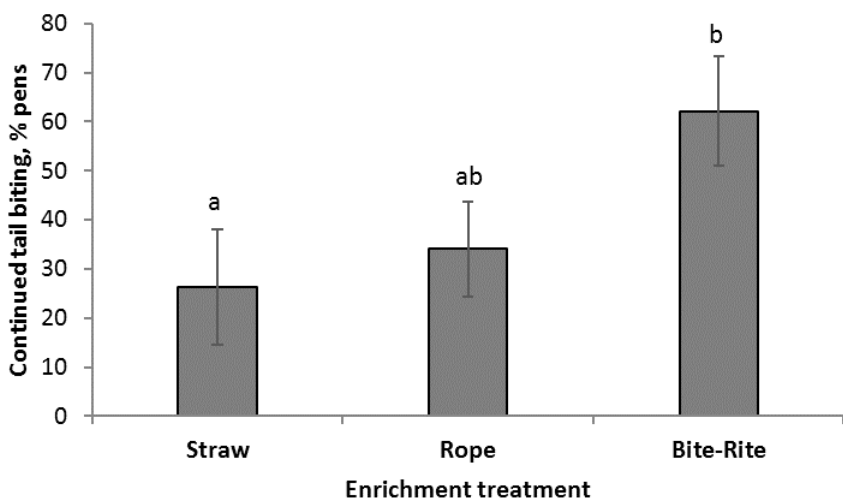
Figure 2. Percentage of pens with an escalation in tail damage after the initial outbreak presented as least squares mean (LSmean) (±standard error (SE)) according to treatment. Different superscript (a, b) indicates a significant difference of p < 0.05 between treatments.